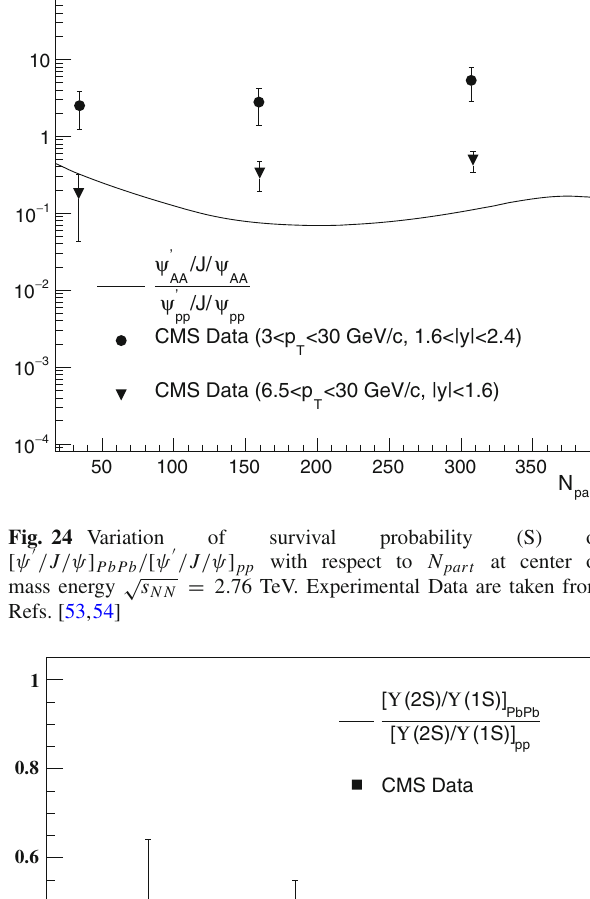
Fig. 23 Variation of survival probability (S) of ϒ( 1 S ) and ϒ( 2 S ) with respect to N part at center of mass energy mental Data are taken from Refs. [53,54]